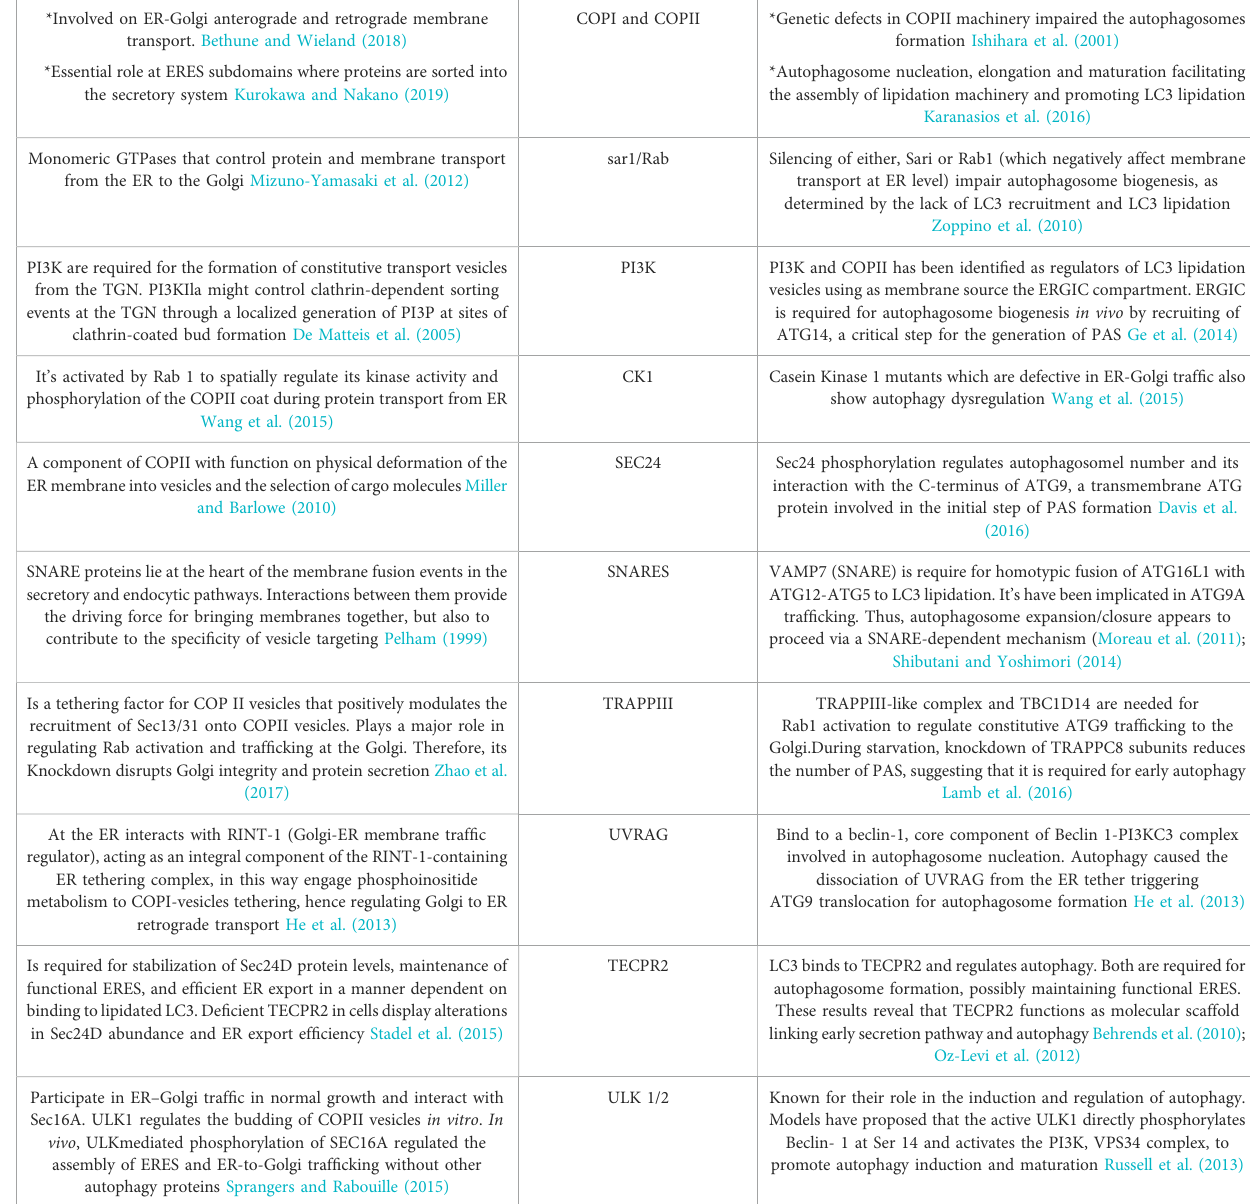
TABLE 1 Common regulators of the ER-Golgi early secretory pathway and autophagy. The main proteins described in this work were summarized in this table describing the role of those protein complexes and regulators on both, the secretory and autophagy pathways. *Involved on ER-Golgi anterograde and retrograde membrane COPI and transport. Bethune and Wieland (2018)